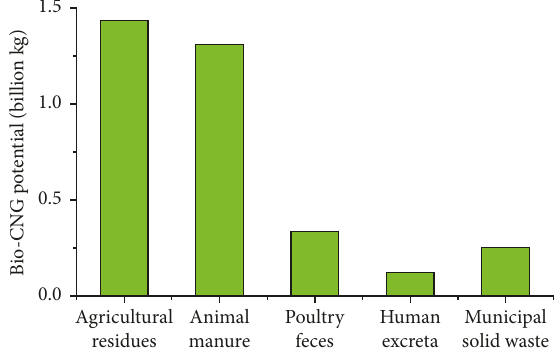
Figure 6: Bio-CNG potential from various biomass